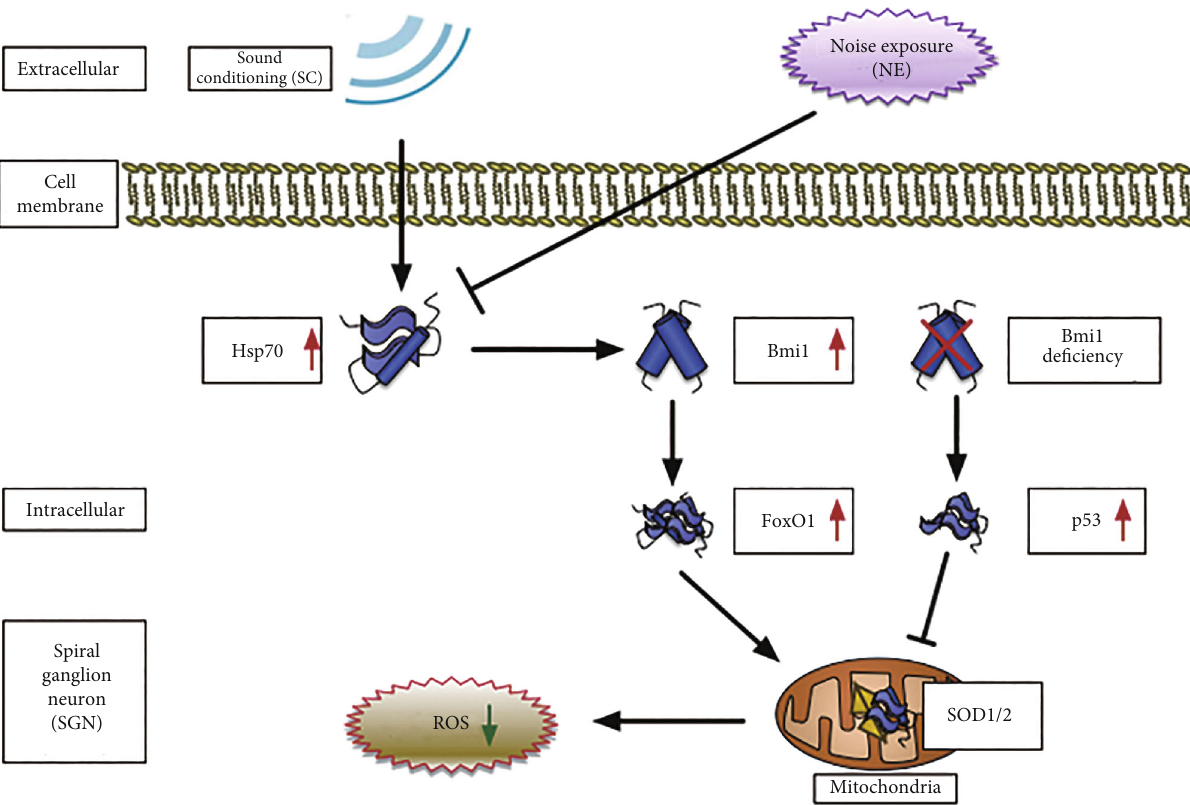
Figure 10: A model for the mechanism of Hsp70-induced Bmi1 upregulation in the protection of sound conditioning against acute acoustic trauma by directly targeting SOD1 and SOD2 regulated by the FoxO1 signaling pathway. Hsp70/Bmi1-FoxO1-SOD1/SOD2 signaling pathway decreases sensitivity in noise-induced trauma following sound conditioning by controlling mitochondrial function and ROS level in rat ’ s SGN. Meanwhile, based on previous studies, other pathway is also involved in Bmi1 de fi ciency-induced ROS accumulation, such as the following: Bmi1 de fi ciency directly leads to p53-mediated repression of antioxidant genes, resulting in increased